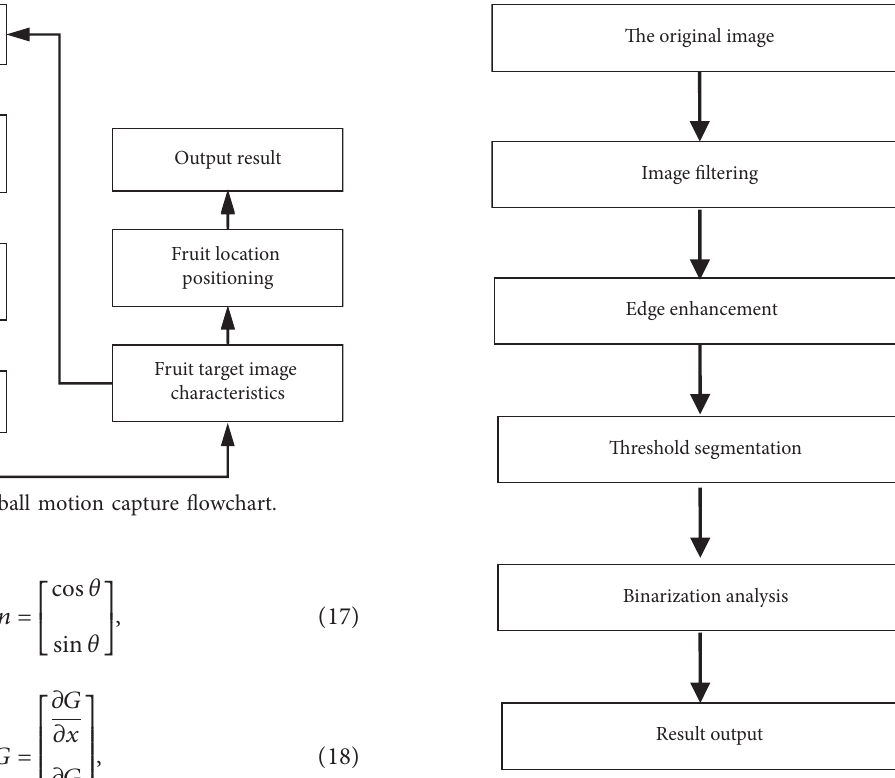
Figure 3: Flowchart of edge